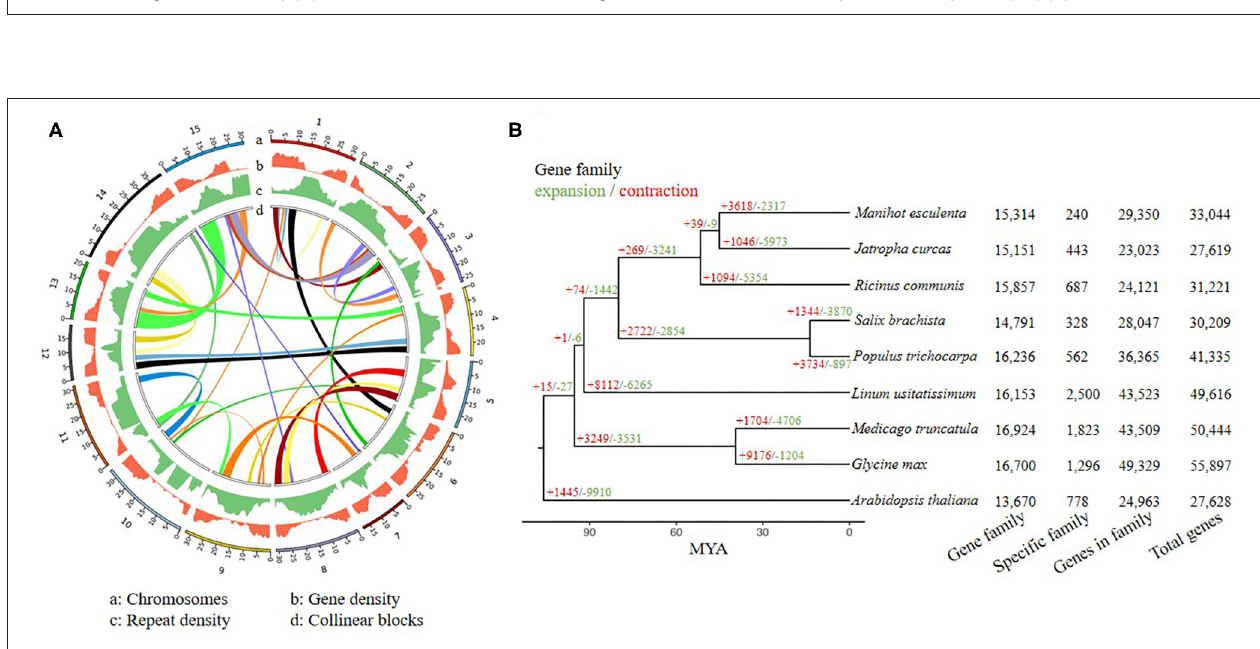
FIGURE 2 | Genomic features and collinear blocks across the YY5 v2.0 genome assembly (A) . Gene family characteristics of Linzan usitatissimum and eight other dicot plants (B) .